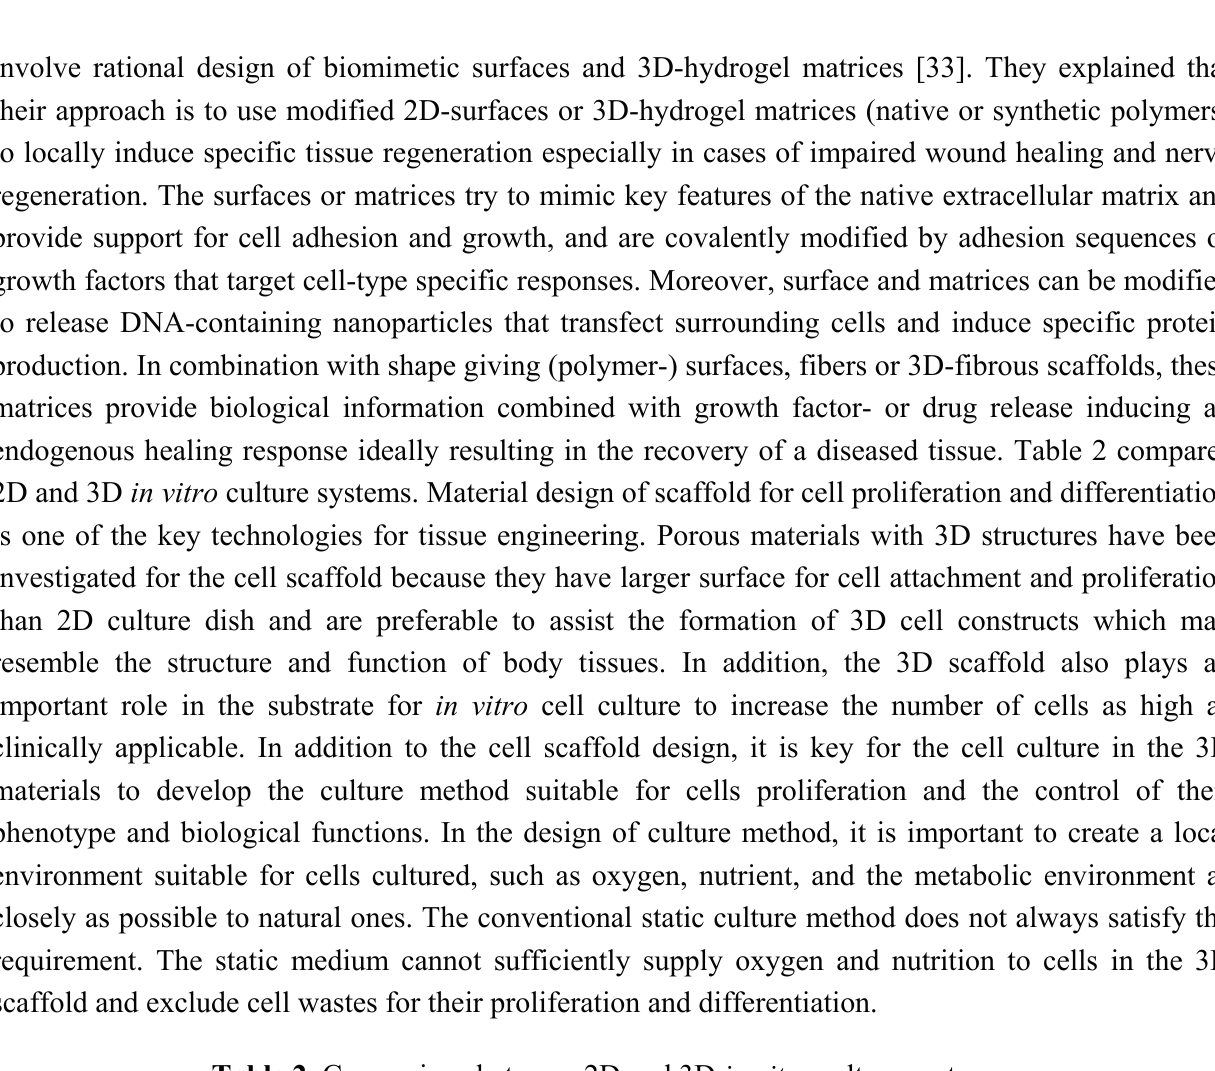
Table 2. Comparison between 2D and 3D in vitro culture